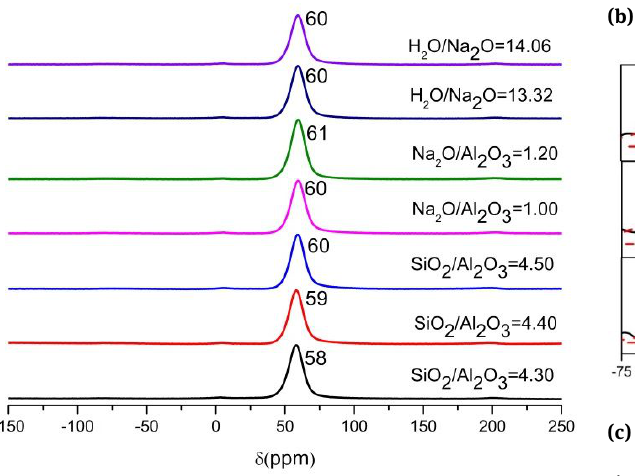
Figure 3: 27 Al MAS NMR results of geopolymers